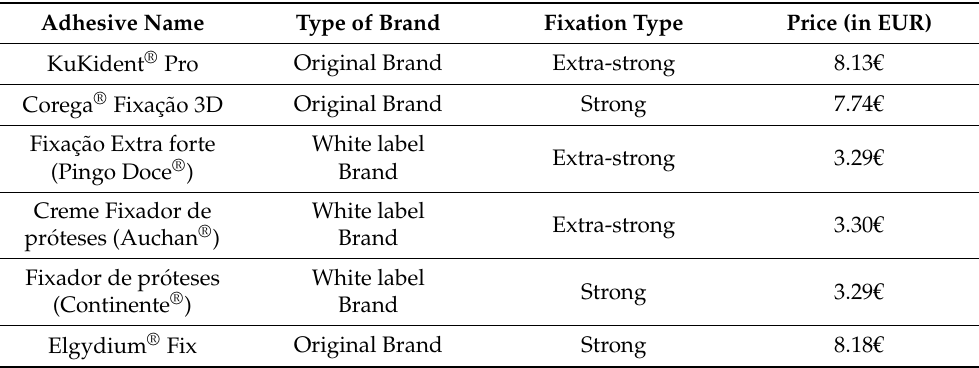
Table 6. The retention capacity of the adhesives in descending order, their characteristics, and their relation with price.